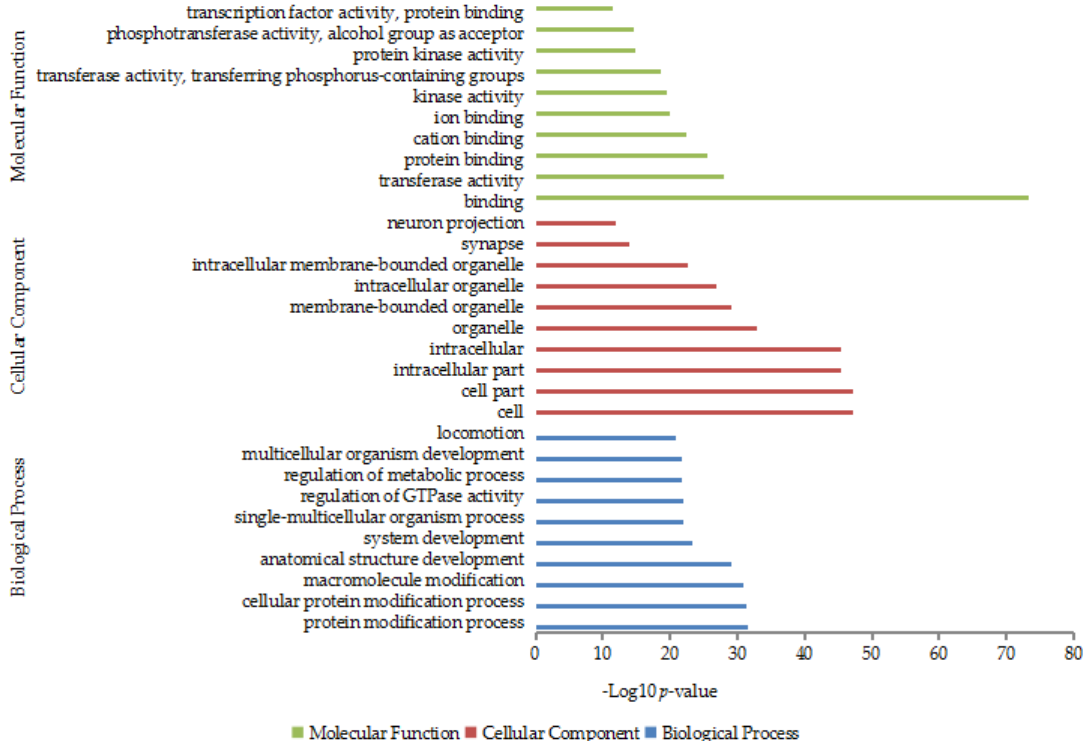
Figure 4. The top 10 terms in each Gene Ontology (GO) category concentrated by the target genes. The X-axis and Y-axis show the calculated results of -Log10 ( p -value) and title of GO terms, re- spectively.